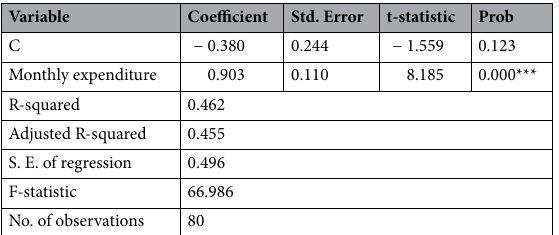
Table 2. Linear regression of sales and expenditure. Dependent Variable: Monthly Sales. ***Significance level at 1%.